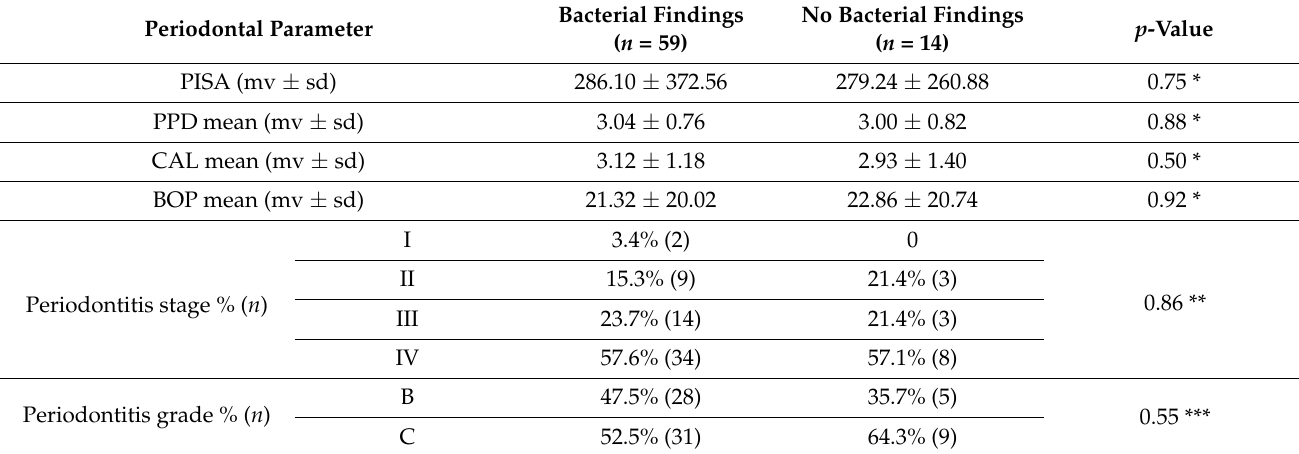
Table 4. Association between bacterial findings in general and periodontal health parameters.